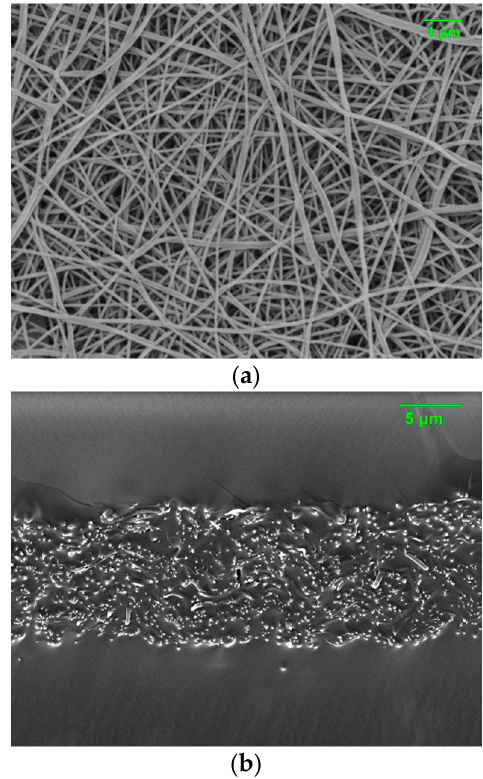
Figure 9. Surface morphology of electrospun nylon nanofibers ( a ) and cross-sectional image of T10N ( b ).